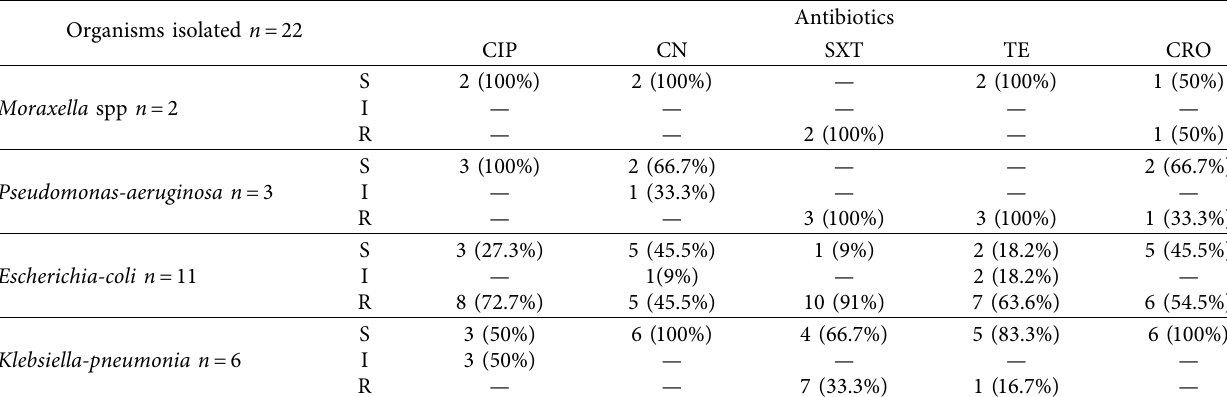
Table 6: Antimicrobial susceptibility pattern of gram-negative bacteria isolated from external ocular infection at Karamara hospital, Jigjiga, eastern Ethiopia,